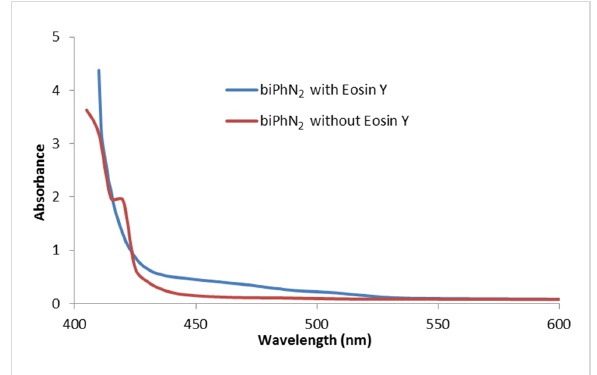
Figure 4: UV–vis spectra of ortho -biphenyldiazonium tetrafluoroborate (biPhN 2 ) in acetonitrile.